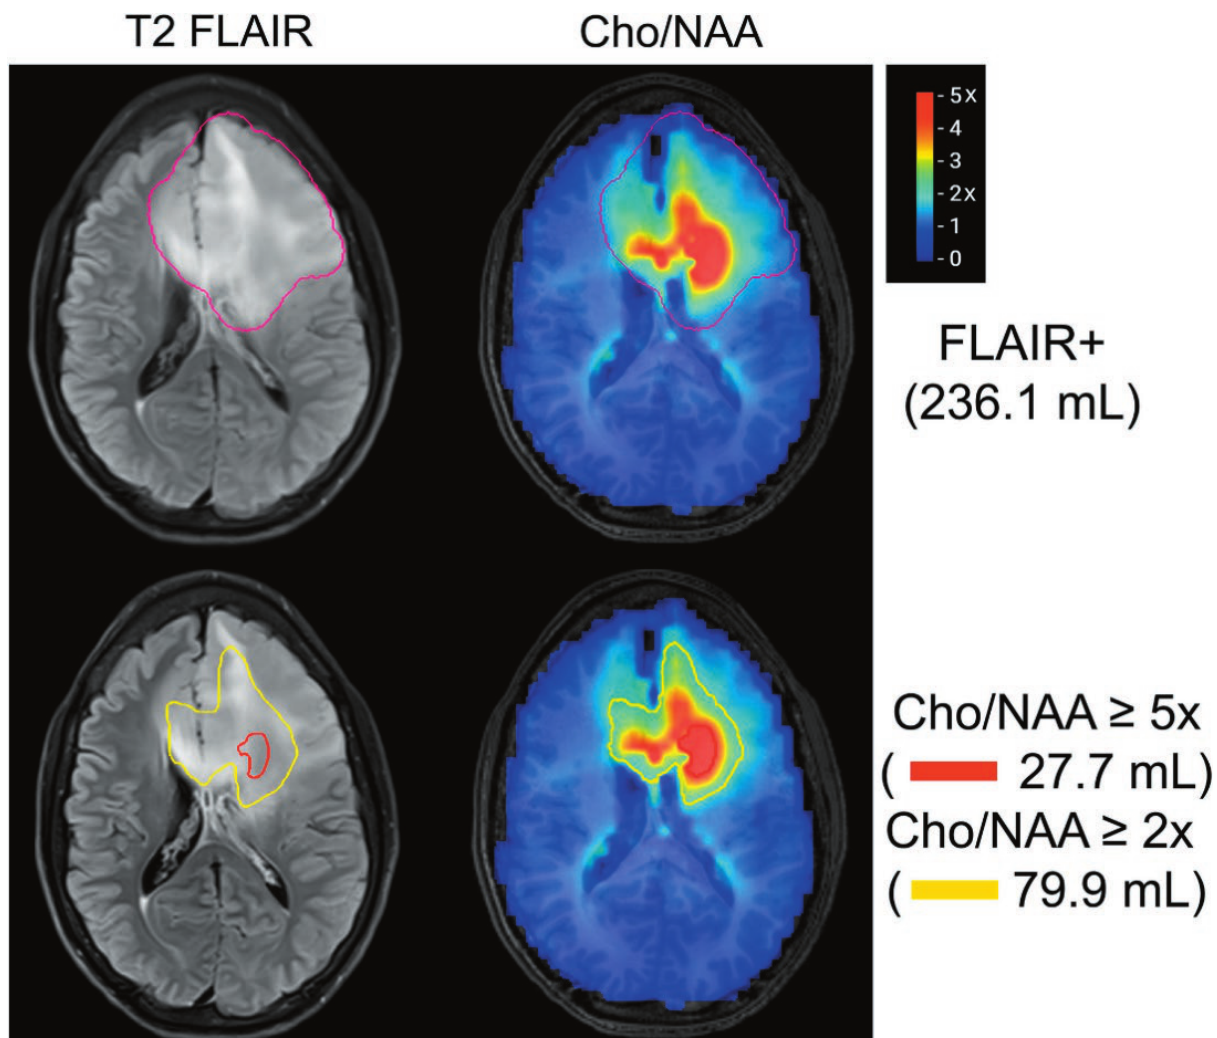
Figure 13. Upper Left Image: FLAIR image of a Grade II Astrocytoma with segmented volume of hyperintensity (pink outline) compared to Upper Right Image: T1 image overlaid with an MRSI colormap of tCho/NAA ratio. Lower Right Image: Outlined volumes show boundary for tCho/NAA of 2x (yellow) and 5x (red). The areas of highest tCho/NAA were targeted for biopsy. The upper and lower images are the same images, only the outlines are different. The tCho/NAA from normal contralateral white matter was set as equal to 1.0. Reprinted by permission from Springer Nature, Reference 168, Copyright